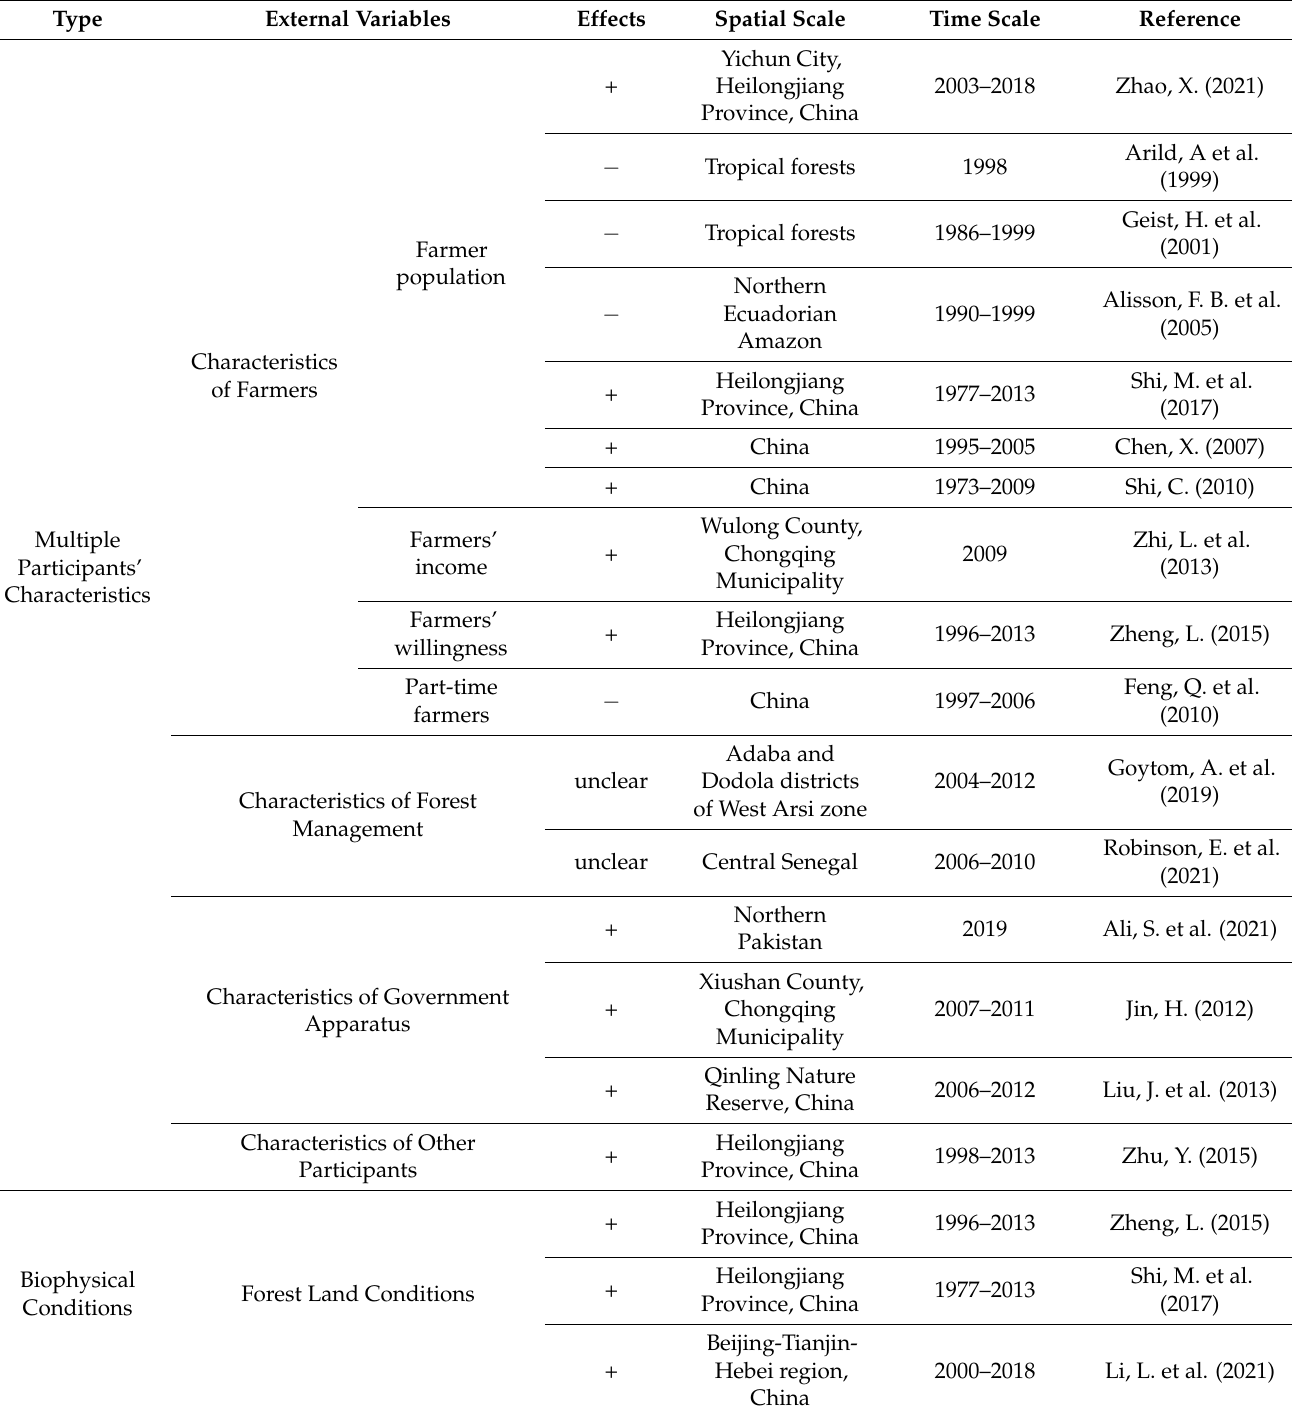
Table A1. Summary of influencing factors and outcomes of multiple parties’ participation in